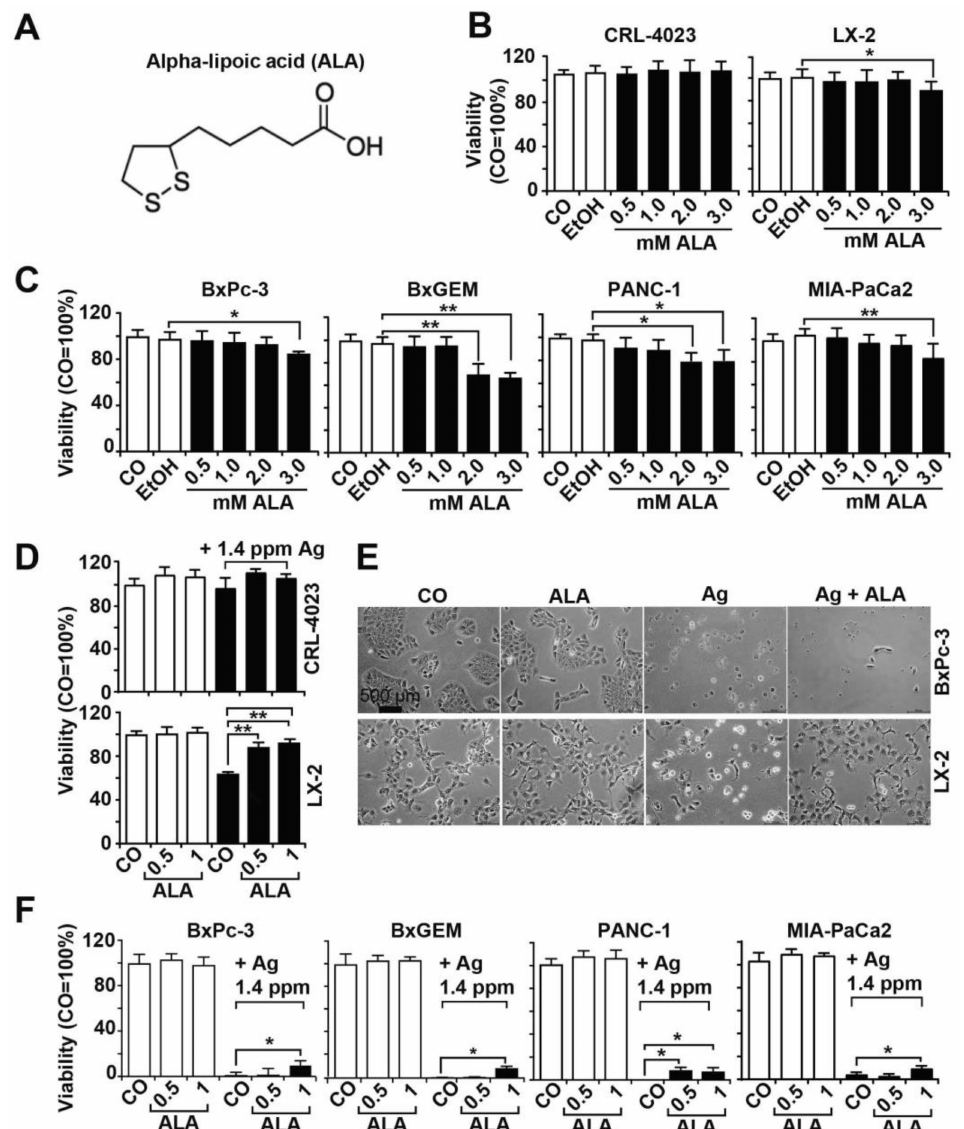
Figure 3. α -Lipoic acid protects nonmalignant cells from AgNP-induced toxicity but not PDAC cells. ( A ) Molecular structure of α -lipoic acid (ALA) with two sulfur atoms at the C6 and C8 positions, which are connected by a disulfide bond. ( B ) Nonmalignant CRL-4023 and LX-2 cells at a concentration of 5 × 10 3 in 100 µ L cell culture medium per well were seeded into 96-well plates and cultured for 24 h. Then, the cells were cultured by adding final concentrations of 0.5, 1, 2 and 3 mM α -lipoic acid to the cell culture medium. The controls were left untreated (CO), or 1.5 µ L 99% EtOH was added. Twenty-four hours later, viability was evaluated by MTT assay. ( C ) Likewise, PDAC cell lines at a concentration of 5 × 10 3 in a 100 µ L cell culture medium per well were seeded in 96-well plates. Twenty-four hours later, the cells were treated and evaluated as described above. ( D ) CRL-4023 and LX-2 cells were incubated in 100 µ L cell culture medium with final concentrations